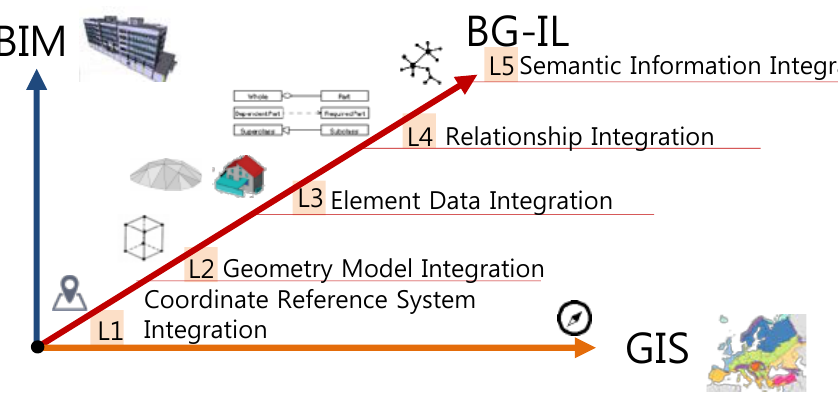
Figure 17. B2G LM rule set and concept.